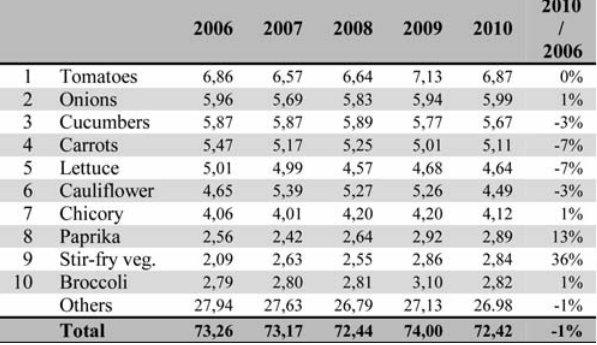
Table 2. Top 10 Domestic purchases of fresh vegetables (in kg per household)